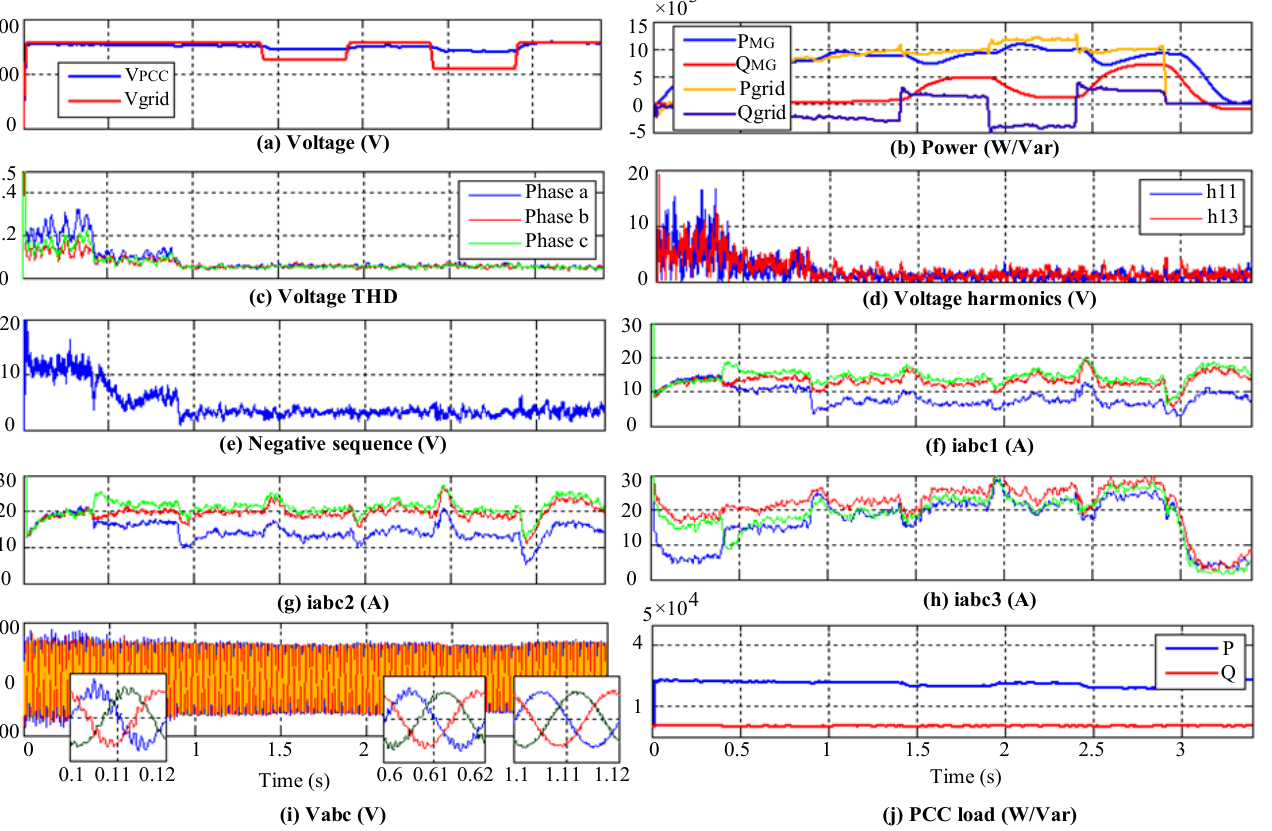
Figure 22. The results of the second scenario: ( a ) peak voltage amplitude of the grid phase and PCC bus; ( b ) grid power and microgrid power; ( c ) amount of voltage THD in the PCC bus; ( d ) 13th and 11th harmonic amplitude of voltage in PCC bus; ( e ) amplitude of negative sequence voltage at PCC bus; ( f ) effective output currents of inverter 1; ( g ) effective output currents of inverter 2; ( h ) effective output currents of inverter 3; ( i ) instantaneous PCC bus voltages; ( j ) power of PCC bus loads. Step 4 ( 1.4 s < t < 1.9 s ) : In this stage, a reduction of 0.15 p.u. occurs in the grid